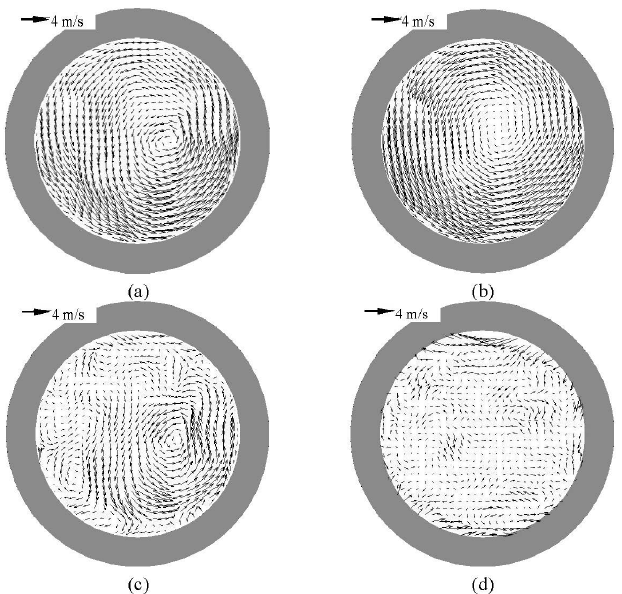
Figure 6. Swirl flow with ensemble ‐ averaged velocity field and spatially filtered results for achieving high and low frequency fluctuations (for maximum valve lifts (MVL) 1.7 mm at the horizontal plane of 5 mm under dead centre (TDC)). ( a ) Instantaneous velocity filed; ( b ) ensemble ‐ averaged mean velocity field; ( c ) low ‐ frequency fluctuating velocity field; ( d ) high ‐ frequency fluctuating velocity field.